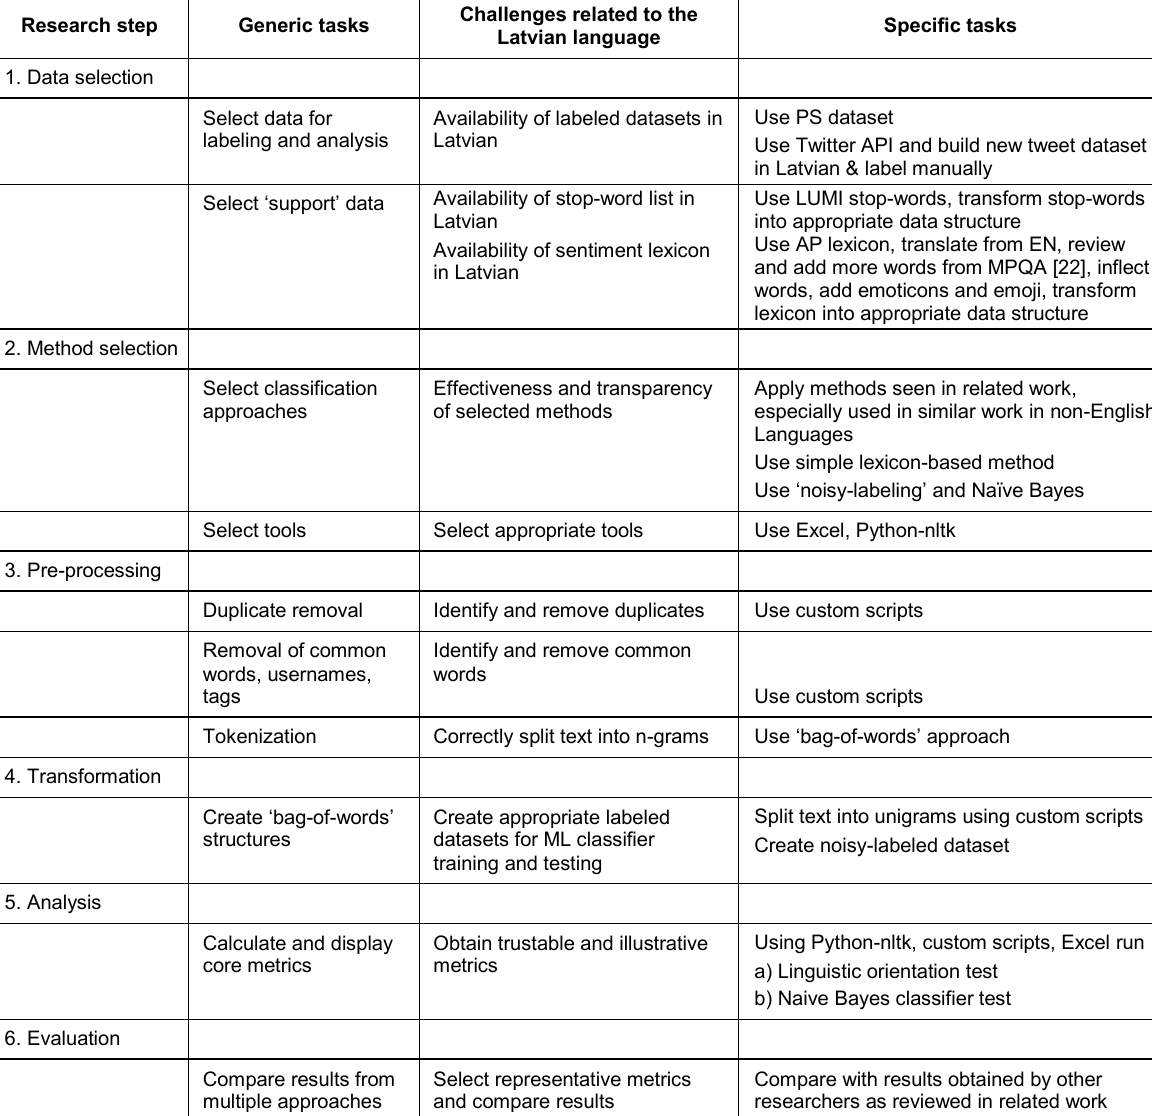
Table 1. Research steps, tasks, challenges and